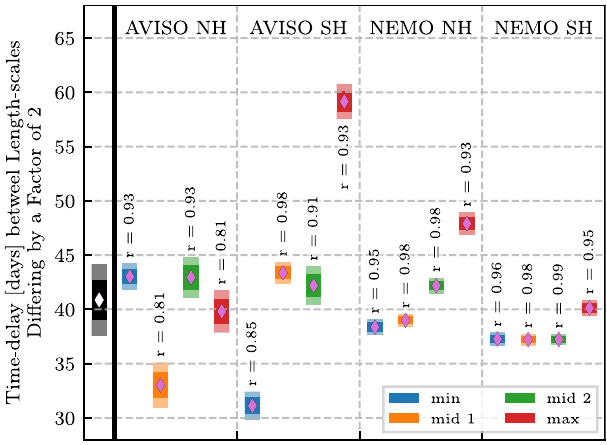
Fig. 7 |Regressionanalysissummary. Regression slope estimates and con fi dence intervalsforeachofthedatasetsshowninFig.S3.Verticaldashedlinesseparatethe data sources, with the text along the top indicating the source data and hemi- sphere. Diamonds indicate the regression slope estimate, dark envelopes the 75% con fi denceinterval,andlightenvelopesthe95%con fi denceinterval.The r -valuefor each regression fi t is printed alongside the corresponding slope distribution. The left-most illustration, separated by athickblackline,presents themean(diamond) andcon fi dentintervals(envelopes)acrossthe16regressionanalyses.Inthelegend, ‘ min ’ means the lowest 10% z-score, ‘ mid ’ the two middle-most 10% groups, and ‘ max ’ the highest